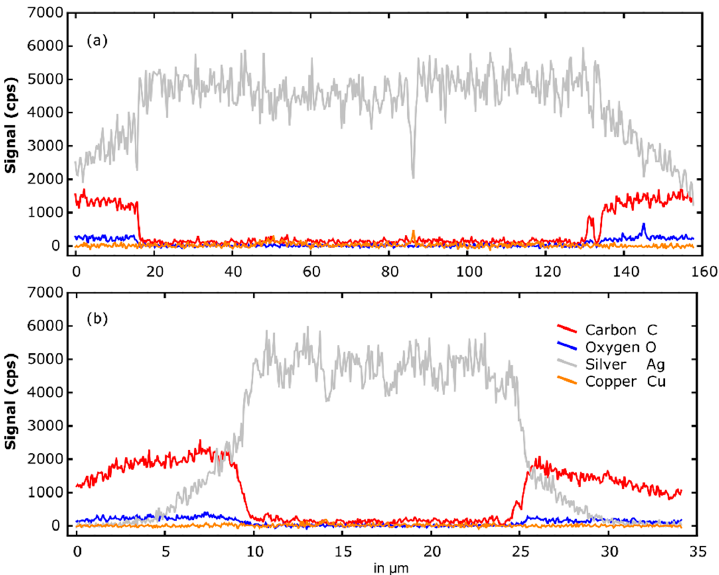
Figure 5. Longitudinal ( a ) and lateral ( b ) EDX line-scans taken on single uncovered wire on sample treated 1 s in H 2 plasma (distance H = 0.35 mm).